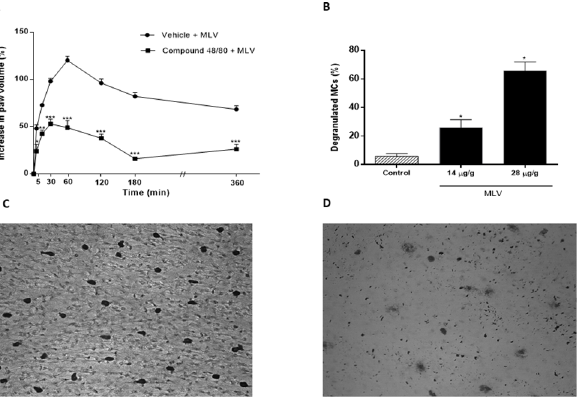
Fig 2. Participation of mast cells (MCs) in paw edema induced by Micrurus lemniscatus venom. (A) Groupsof rats weretreated with compound48/80 (0.1 to 5.0 mg/mL i.p. twice a day for 5 consecutive days) or an equal volumeof vehiclei.p. (control) before MLV injection(5 μ g/paw).Edema was evaluatedusinga plethysmometer at the time points shown.Data are expressed as % increasein paw volumecomparedwith the controlpaw. (B) Degranulation of mesenteric mast cellswas assessed15 min after venom injectionby countingthe percentage of cells with extrudedgranulesin the histological preparation.(C, D) Toluidineblue stainingof mesenteric mast cells treated with apyrogenic saline (C) or MLV (2.8 μ g/g)(D). The mesentery had minimalmast cell degranulation after i.p. injectionwith apyrogenic salineand extensivemast cell degranulation after injectionwith MLV. Values are the mean ± SEM of five animals. * p < 0.05 comparedwith control